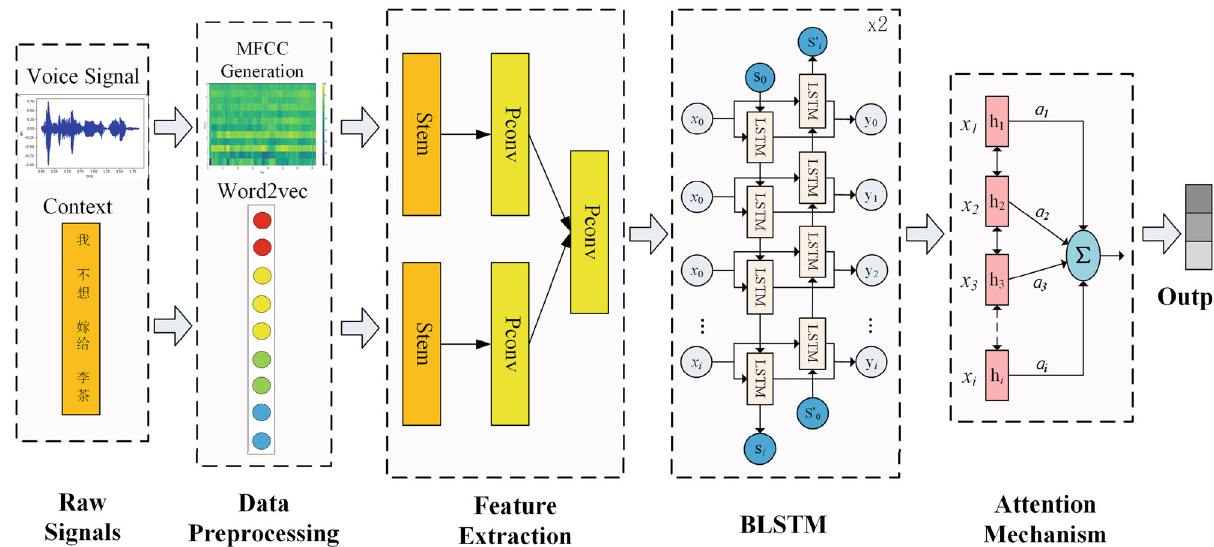
Fig. 1 Dual-modal emotion recognition framework